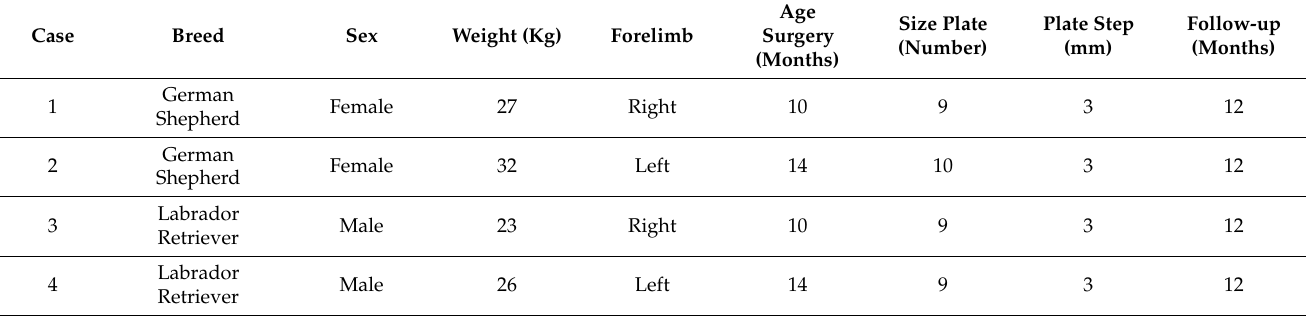
Table 1. Descriptive results of 33 elbows in 26 dogs treated by arthroscopy and